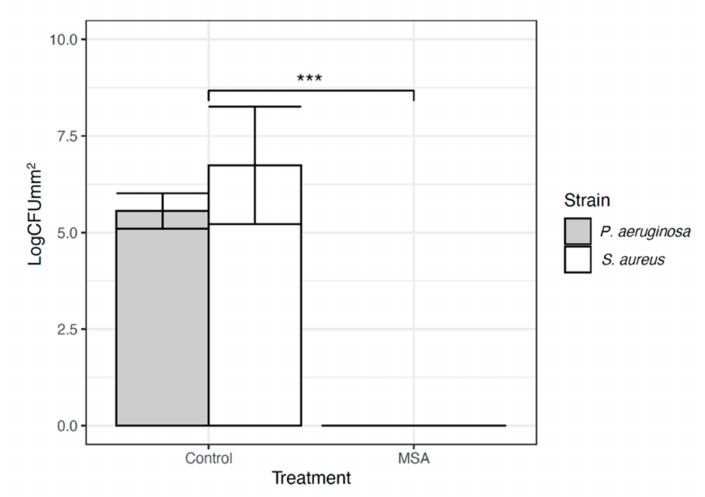
Figure 1. Results for MBEC Assay ® for P. aerurinosa (grey bar) and S. aureus (white bar) reported in CFUmm 2 . The error bars are demonstrating standard deviation. The *** demonstrates statistical significance of p <